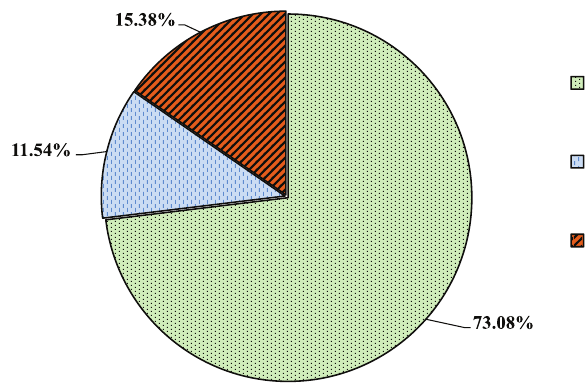
Supplementary Figure C. Coverage of relations occurring in Epilepsy